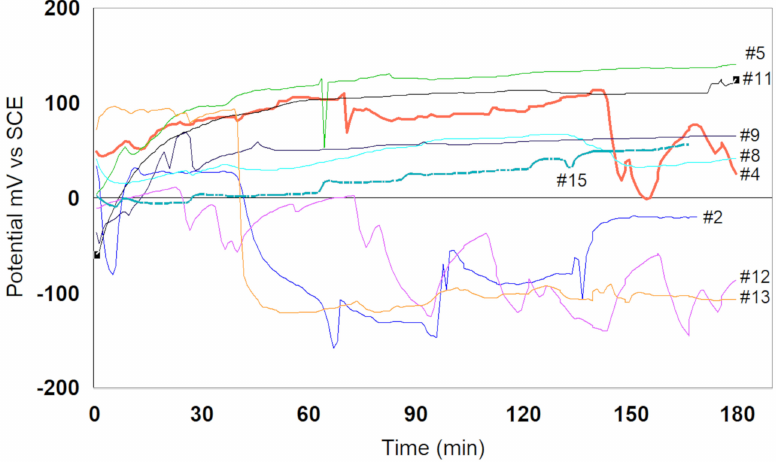
Figure 21. The open circuit potentials measured on the internal surfaces of the